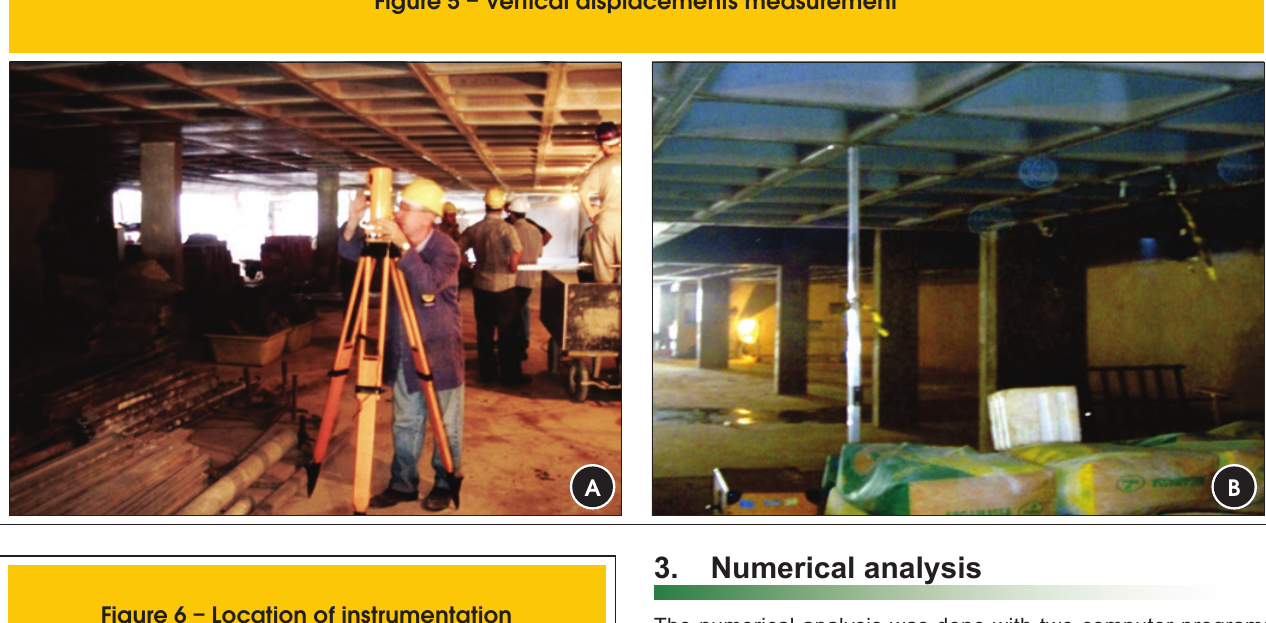
Figure 5 – Vertical displacements